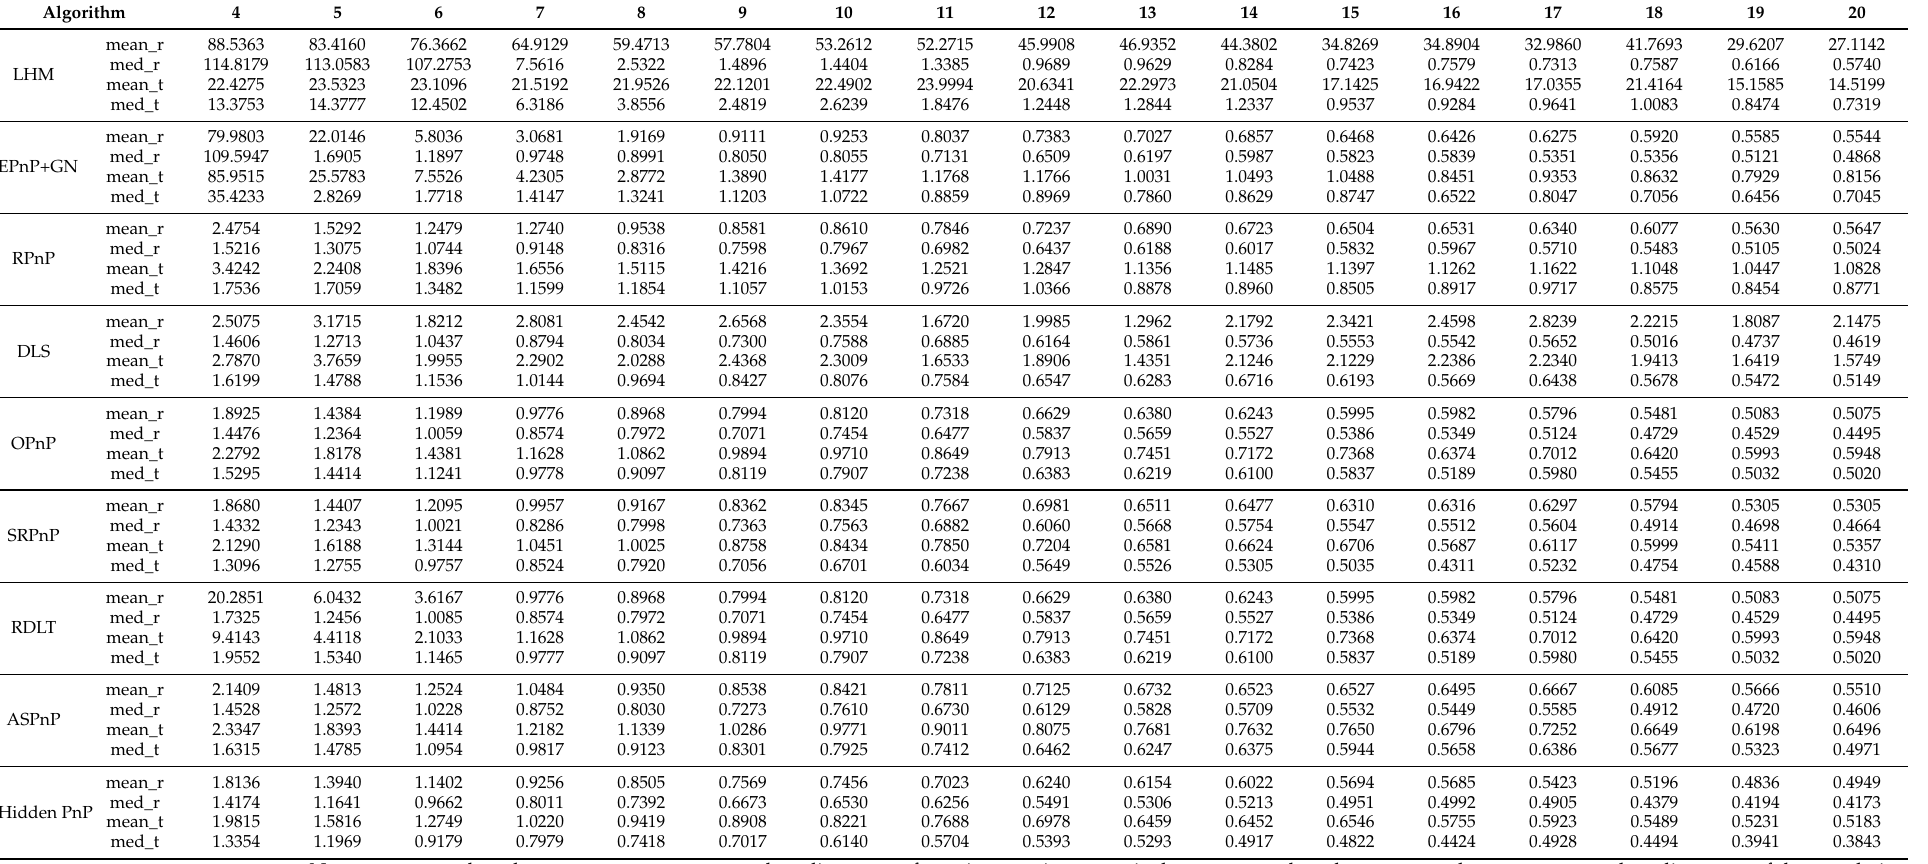
Table A3. Error comparison in the Quasi-Singular